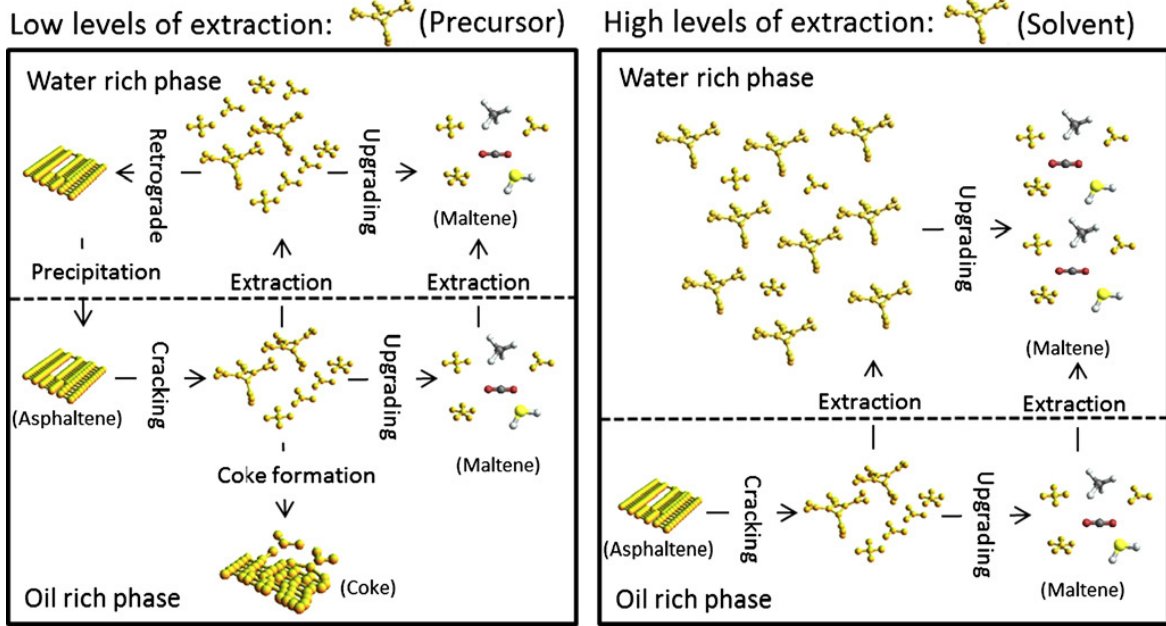
Figure 4. Schematic representation of the proposed mechanism of coke suppression. ( Left ) Low levels of extraction of asphaltene core; ( Right ) high levels of extraction of asphaltene core. Reproduced with permission from [26], published by Elsevier Limited,